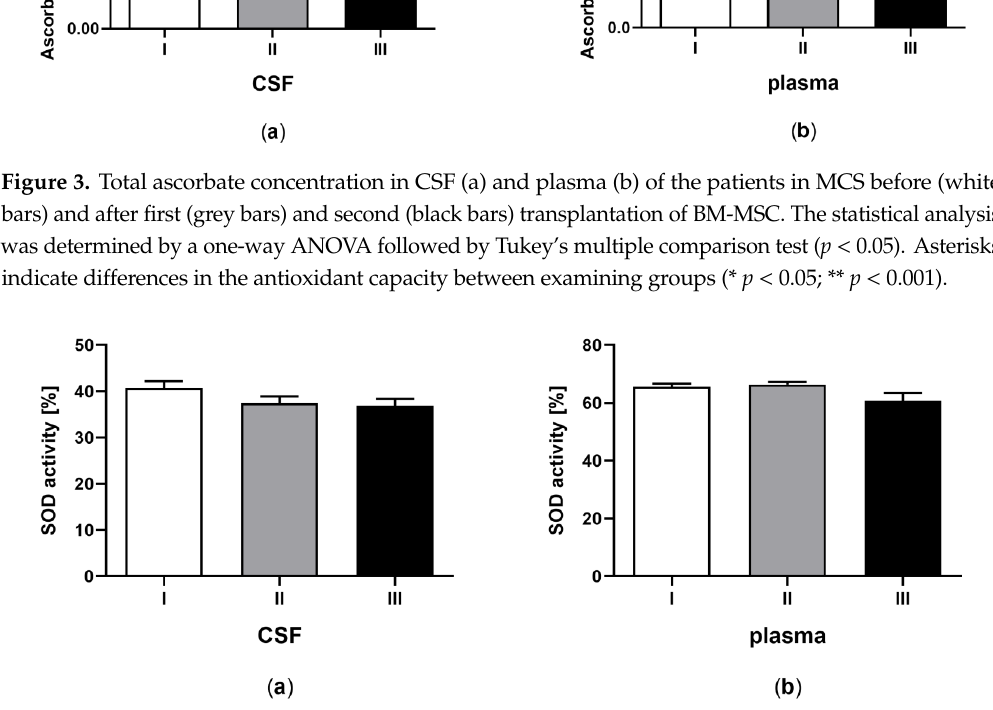
Figure 4. Superoxide dismutase (SOD) activity in CSF (a) and plasma (b) of the patients in MCS before (white bars) and after first (grey bars) and second (black bars) transplantation of BM-MSC. The test ( p <